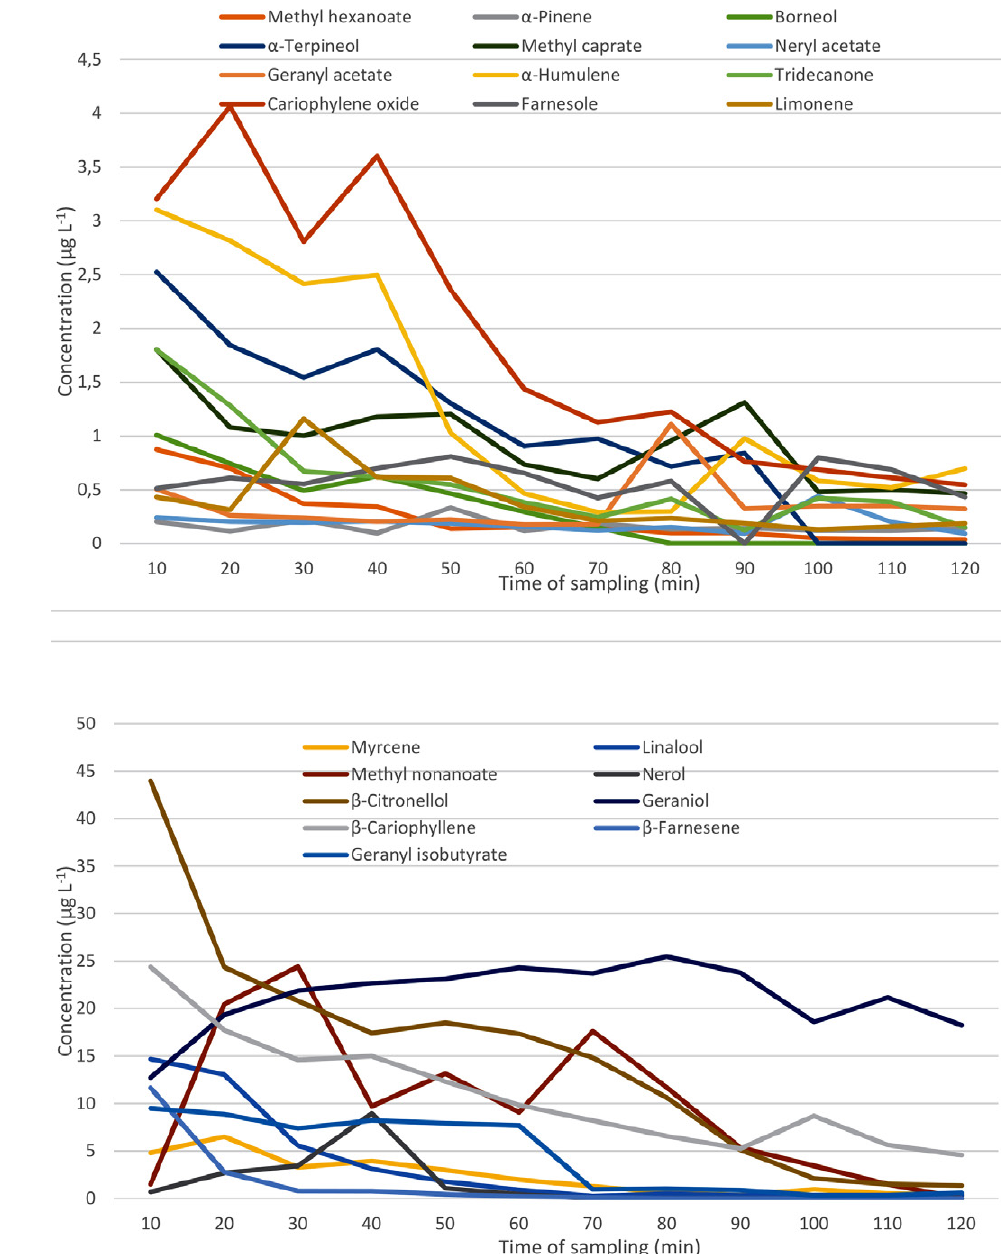
Figure 3a and 3b. Transition of hop essential oil components during wort